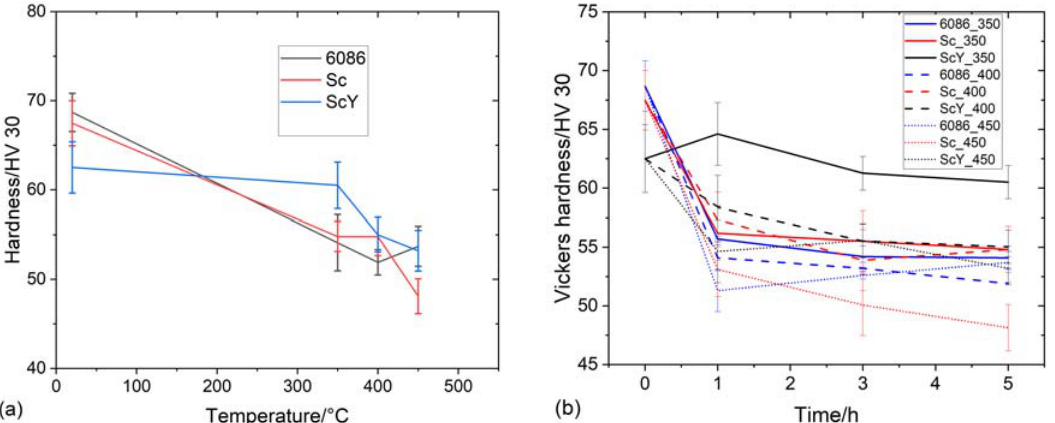
Figure 16. Heat treatment of the alloys in the homogenized condition. ( a ) The effect of the five-hour isochronal ageing on the hardness of the investigated alloys at different temperatures. ( b ) The effect of time on hardness at isothermal treatment at 350 °C, 400 °C, and 450 °C.